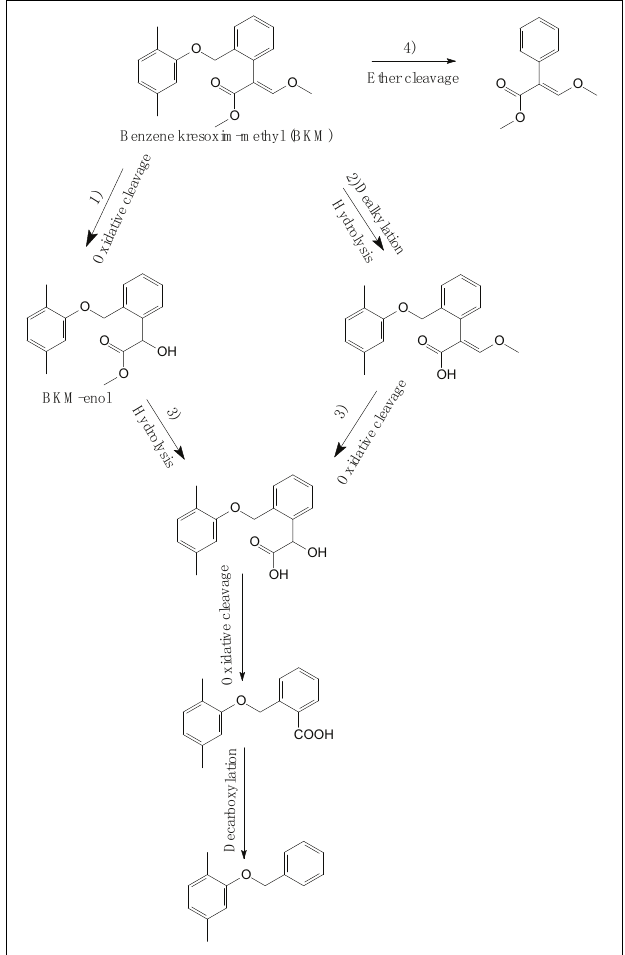
FIGURE 7 | Proposed degradation pathways of benzene kresoxim-methyl (BKM) in aerobic soils (based on Wang et al.,